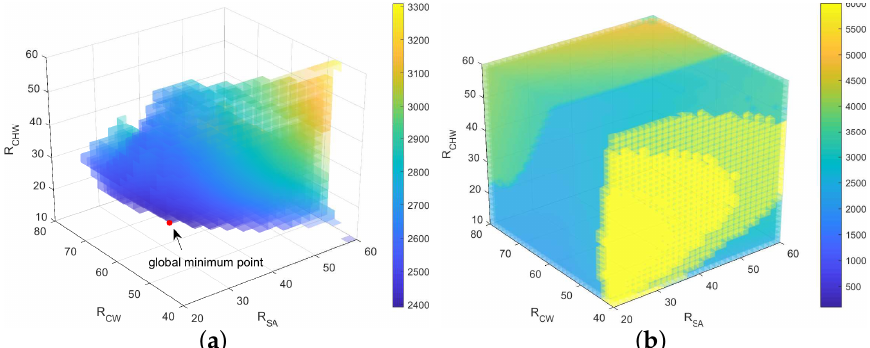
Figure 8. Distributions of the total power consumption from two angles: ( a ) the distributions satisfying the constraint of indoor temperatures ( b ) all the